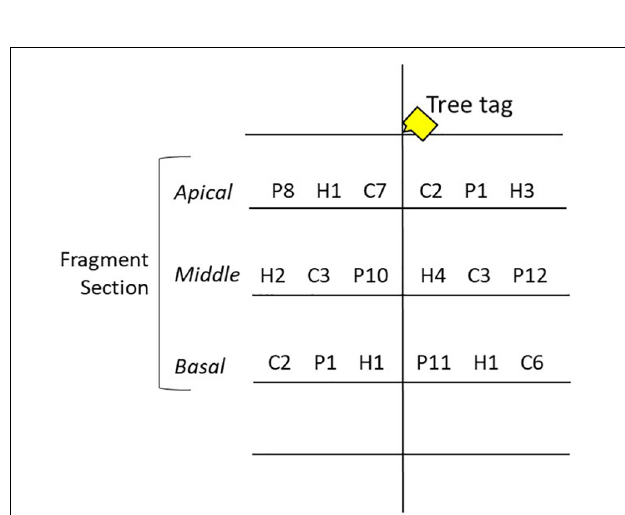
FIGURE 3 | Nursery tree experimental setup. Coral fragments were placed on the middle three tree branches shown here with a letter and number value. Fragment sections were individually tagged. C, P, and H denote taxa [ A. cervicornis, A. palmata, and A. prolifera (hybrid), respectively], and numbers denote genotype. The fragment section changed branches between trees at each site. See Supplementary Figure 2 for full experimental